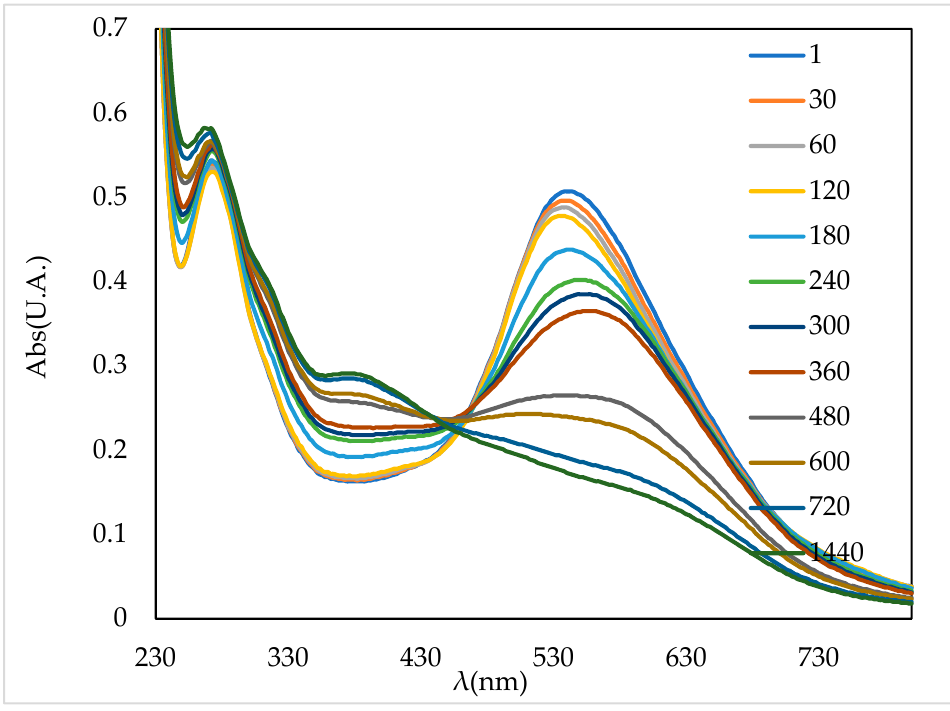
Figure 10. Bio-degradation spectra of AB 113 in laccase medium.